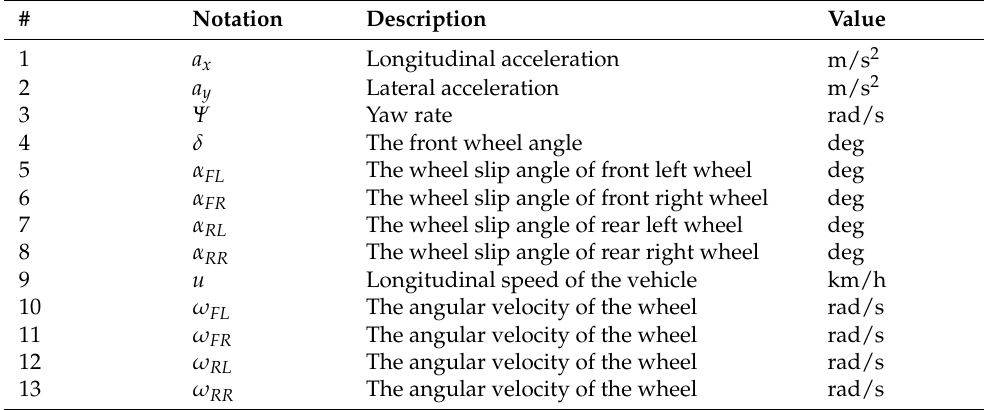
Table 1. Signals used in the LM-MMSOFNN algorithm.